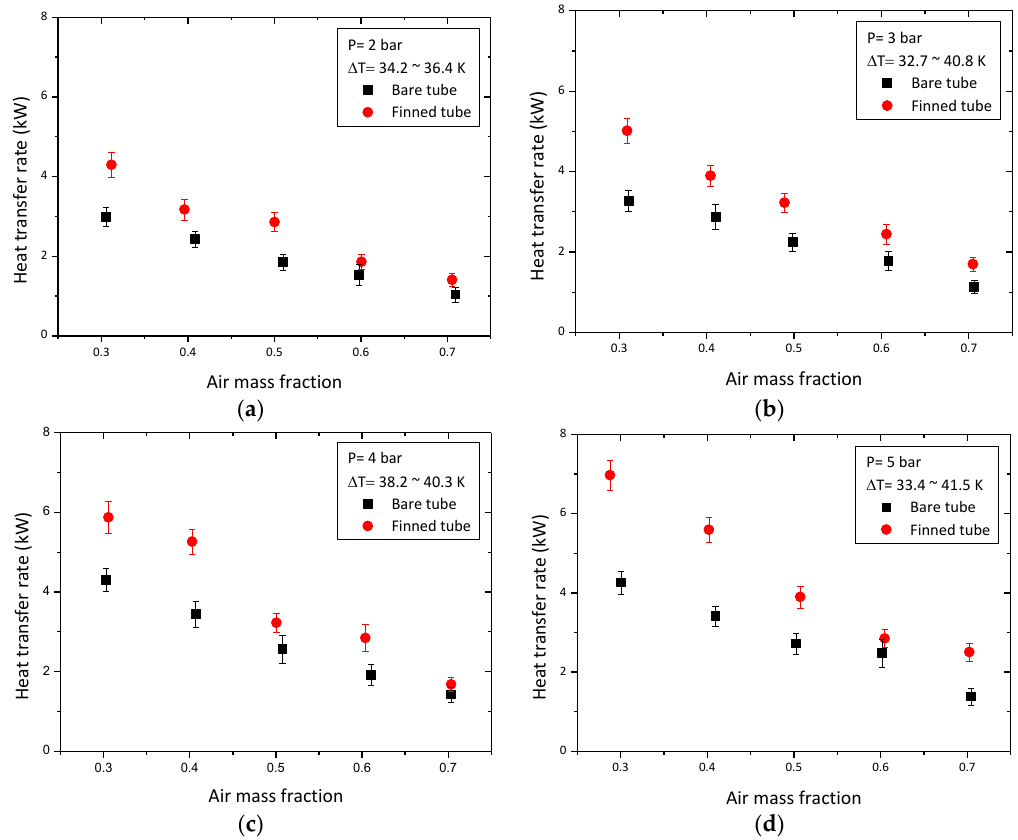
Figure 11. Comparison of the heat transfer rates between the finned tube and the bare tube at ( a ) 2 bar, ( b ) 3 bar, ( c ) 4 bar, and, ( d ) 5 bar.